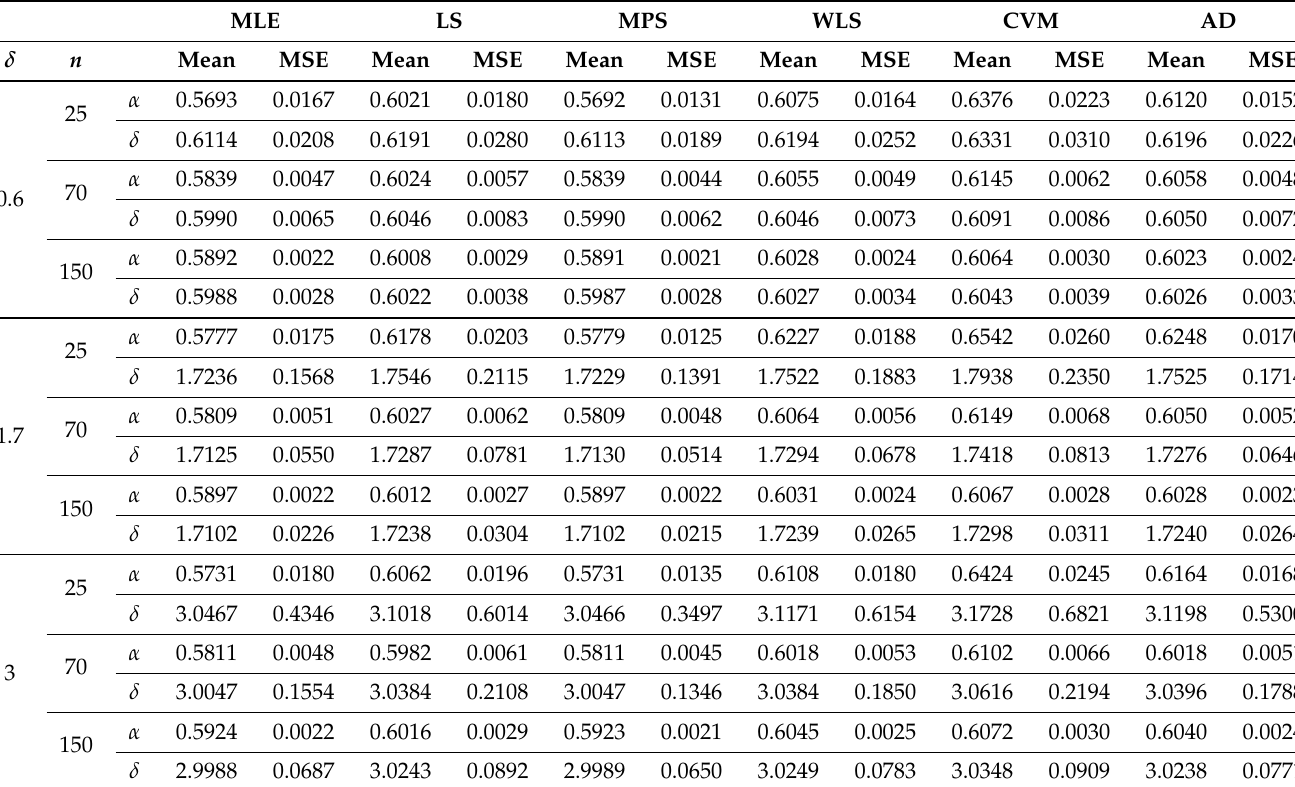
Table 1. Mean and MSE of the MLE, LS, MPS, WLS, CVM and AD estimate for MKITL distribution when α =